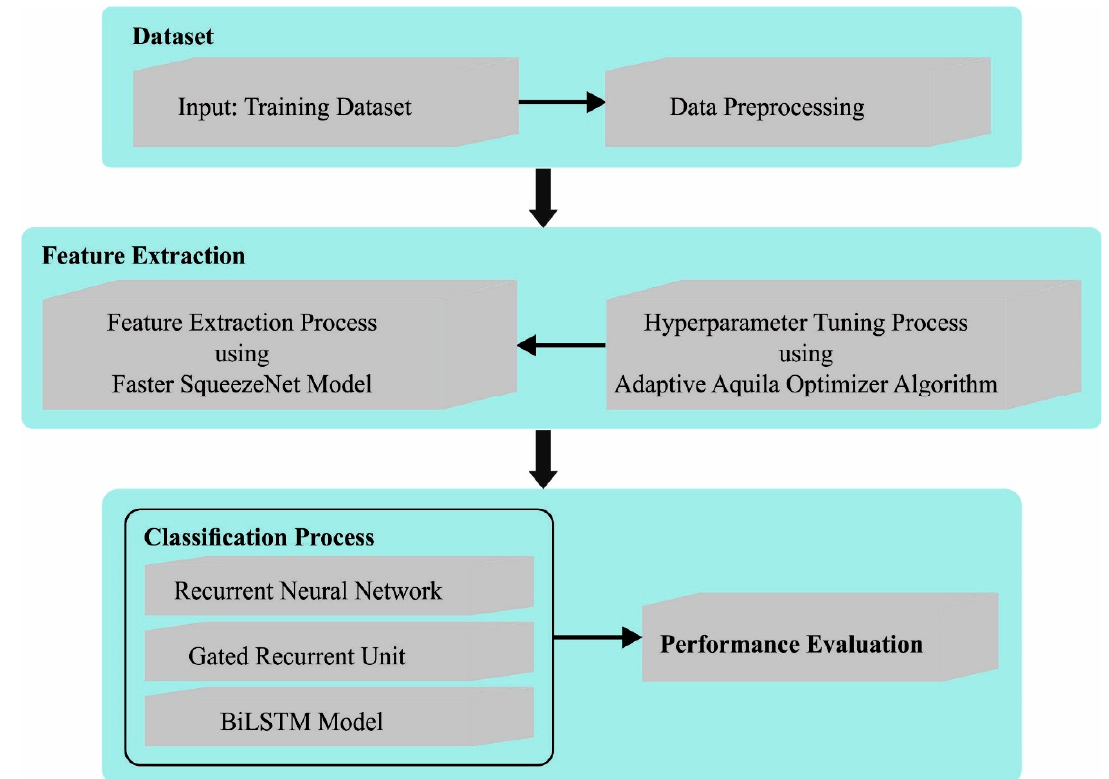
Figure 2. The overall flow of AAOXAI-CD approach.